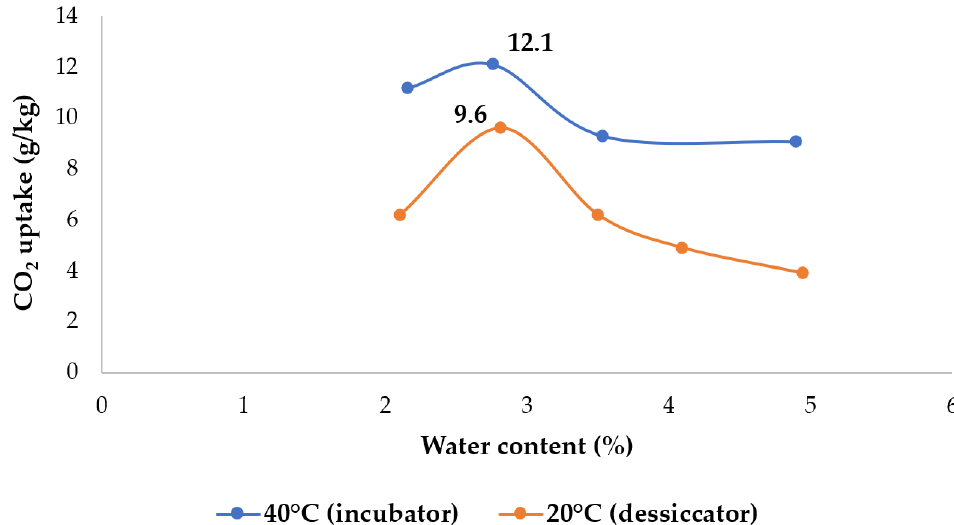
Figure 11. Effect of the water content on the CO 2 uptake (at 20 ◦ C and 40 ◦ C) for OC 12–20 (one accelerated carbonation test for these RCAs at these water